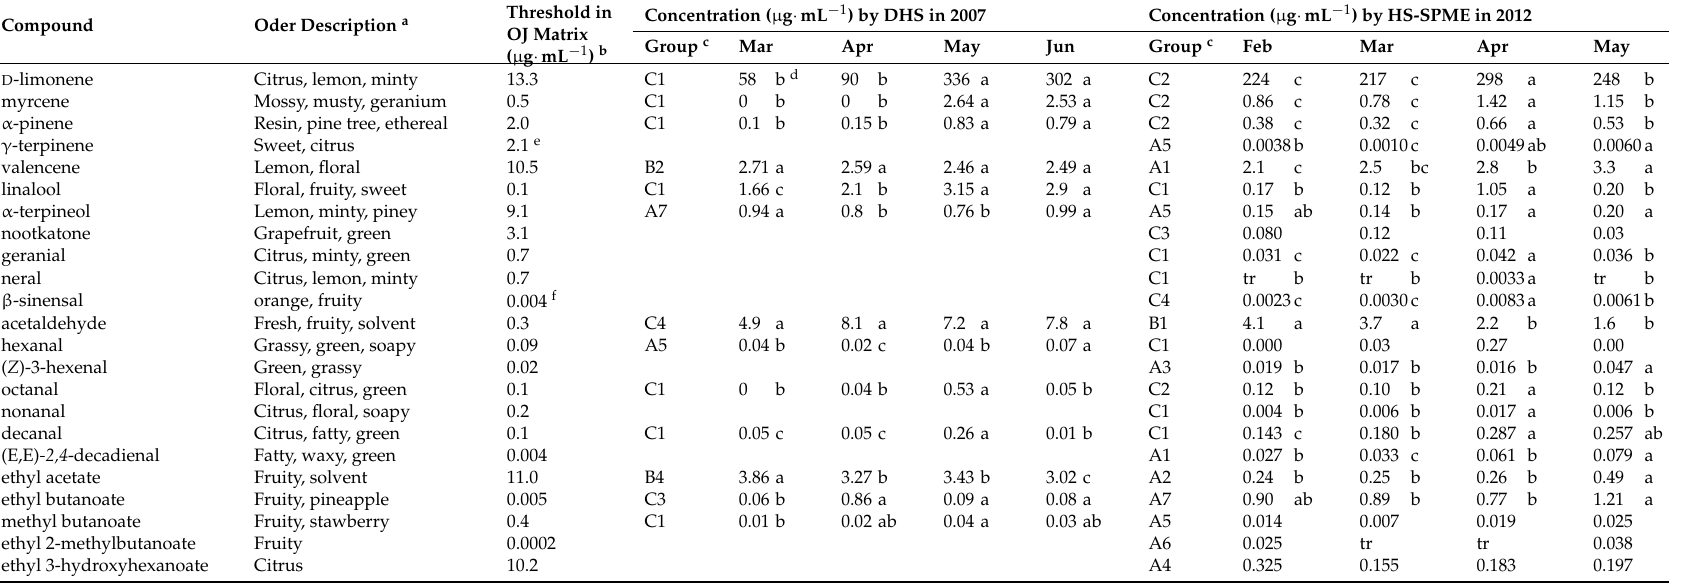
Table 2. Change of 23 important comtributers to orange juice aroma quality in juices extracted from “Valencia” oranges harvested from March to June 2007 and Feburary to May